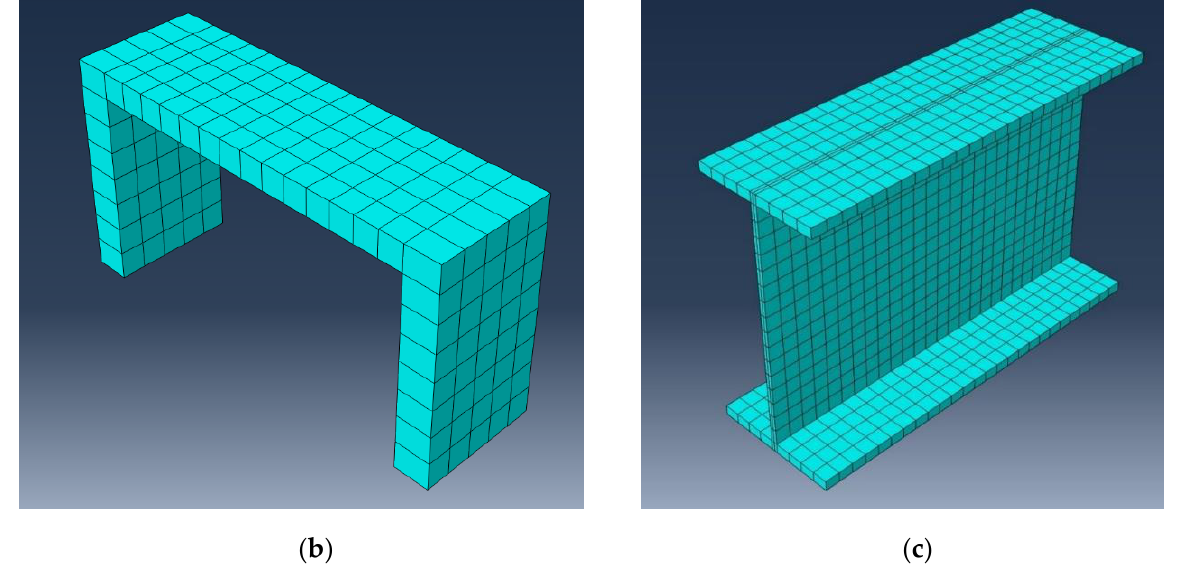
Figure 5. The modelled mesh and element lattices: ( a ) main model, ( b ) channel section and ( c ) IPE beam.